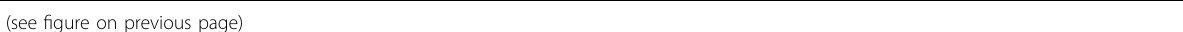
Fig. 1 Depletion of CBP and/or Ku70 inhibited cell proliferation and caused cell death. A (a) CBP mRNA expression level in human melanoma cells line A375 cells; (b) CCK-8 assay on cell proliferation after transfection CBP siRNA; (c) Ku70 mRNA expression level in human melanoma cells line A375 cells; (d) CCK-8 assay on cell proliferation after transfection Ku70 siRNA; (e) CCK-8 assay on cell proliferation after transfection CBP siRNA and/or Ku70 siRNA. B Cell death caused by the depletion of CBP in human melanoma A375 cells in 48 h. (a) Control group. (b) CBP siRNA (1 fmol/cell) group. (c) CBP siRNA (2 fmol/cell) group. (d) CBP siRNA (3 fmol/cell) group. (e) NC siRNA group; (f) the statistical analysis of the cell death. C Effects on A375 cell death by co-transfection of CBP siRNA and Ku70 siRNA (24 h). (a) Control group; (b) Ku70 siRNA (70% depletion) group; (c) CBP siRNA (70% depletion) group. (d) Co-transfections of the CBP siRNA and the Ku70 siRNA (60% depletion for CBP and Ku70, respectively); (e) NC siRNA group; (f) the statistical analysis of the cell death rate of A375 cells. D Effects on A375 cell death by co-transfection of CBP siRNA and Ku70 siRNA (48 h). (a) Control group; (b) Ku70 siRNA (70% depletion) group; (c) CBP siRNA (70% depletion) group; (d) co-transfections of CBP siRNA and Ku70 siRNA (60% depletion for CBP and Ku70, respectively); (e) NC siRNA group; (f) the statistical analysis of the cell death rate of A375 cells. Data in all bars are expressed as mean ± SEM ( n = 3). * P < 0.05, ** P < 0.01, # P < 0.05, ## P < 0.01, and n.s denotes P > 0.05, when compared with CBP siRNA (by 70% depletion)